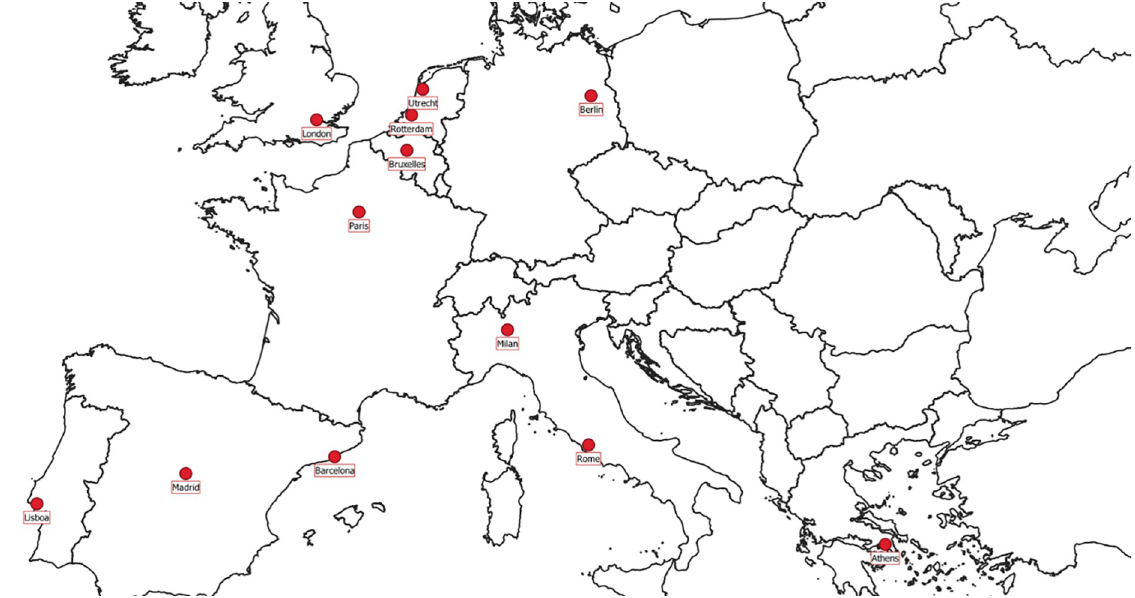
Fig 1. Study domain. Map showing the cities examined in the